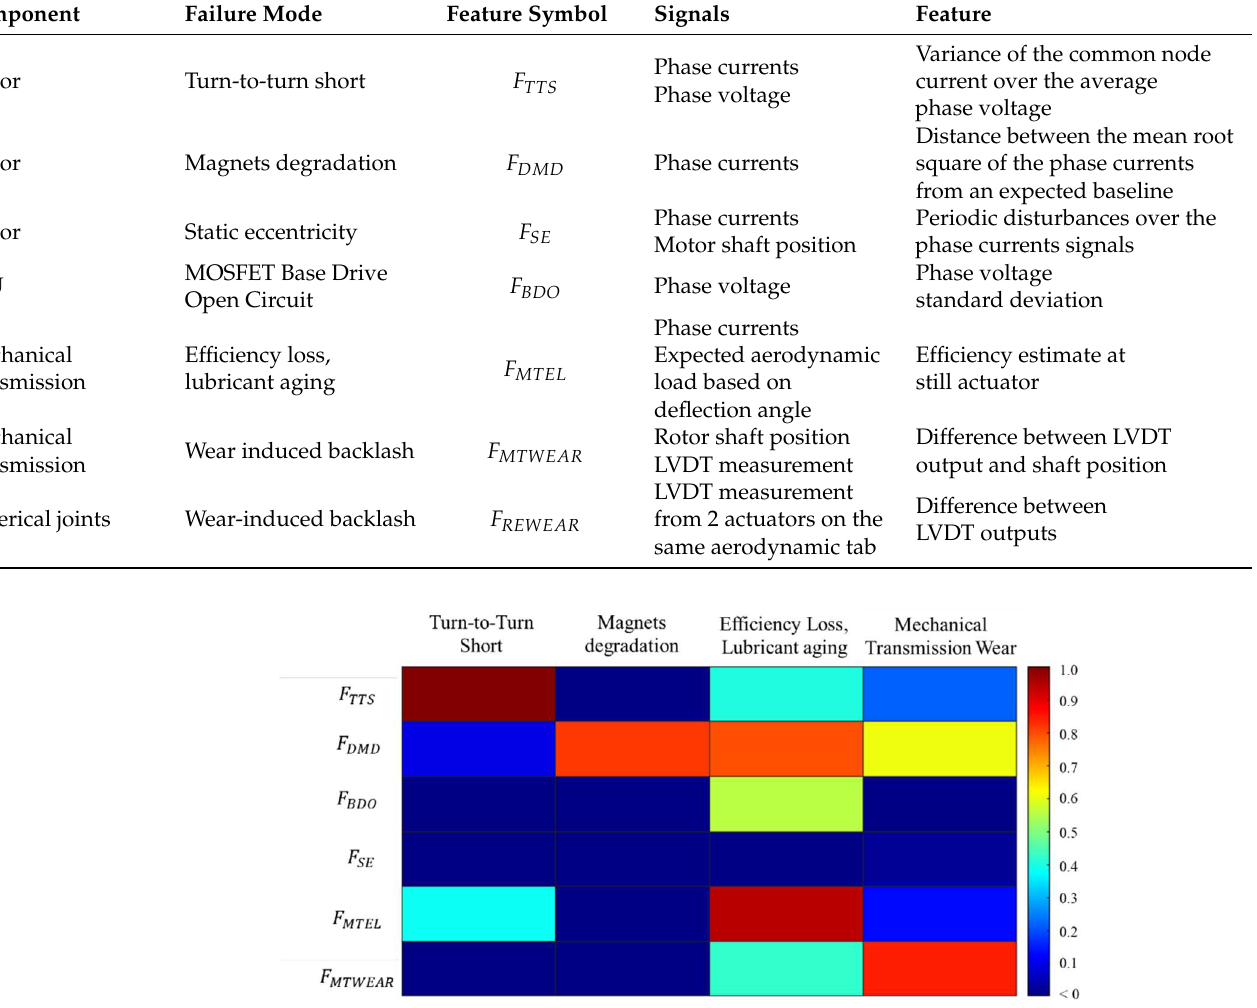
Figure 14. Feature correlation against several failure modes propagation.